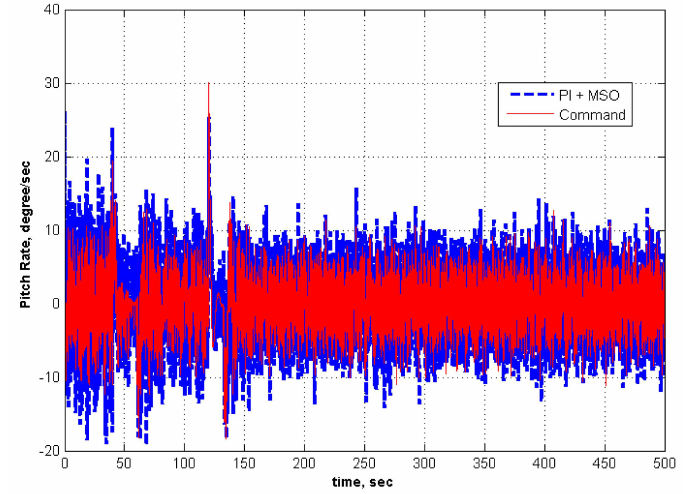
Figure 13. Pitch rate response for 50% C m α in an